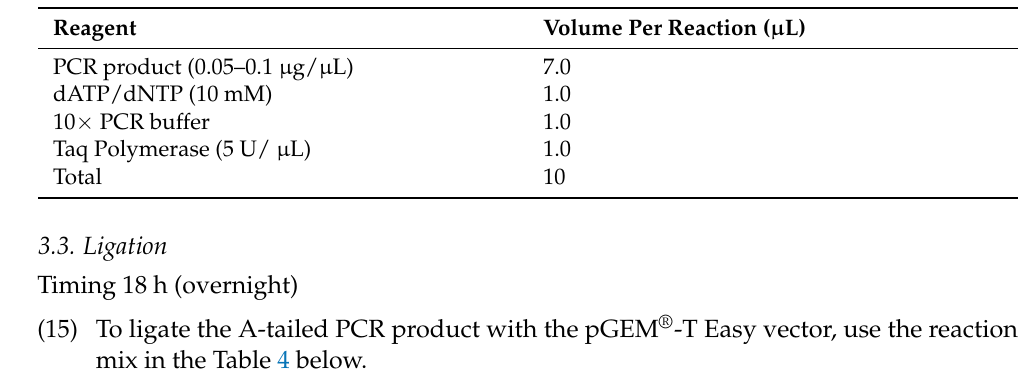
Table 3. Reaction mix for adding A-tails to the PCR products.